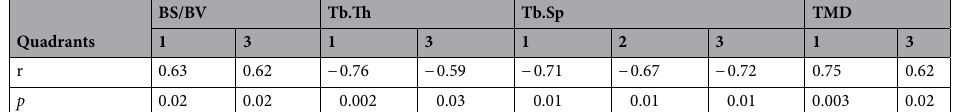
BS/BV Quadrants